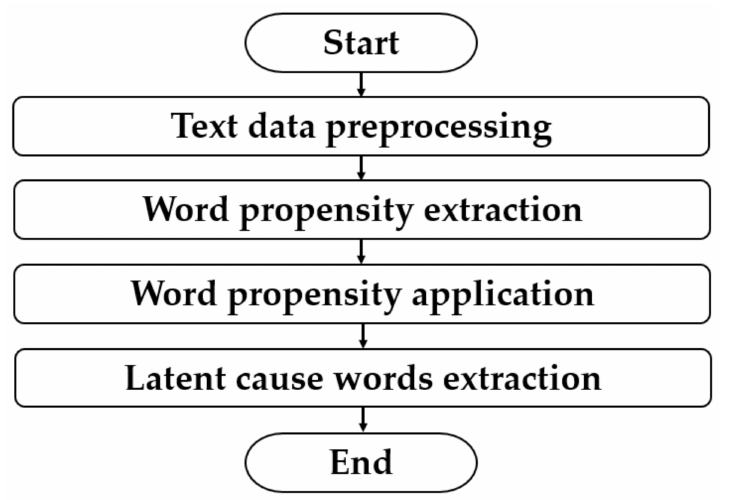
Figure 1. Workflow of our proposed